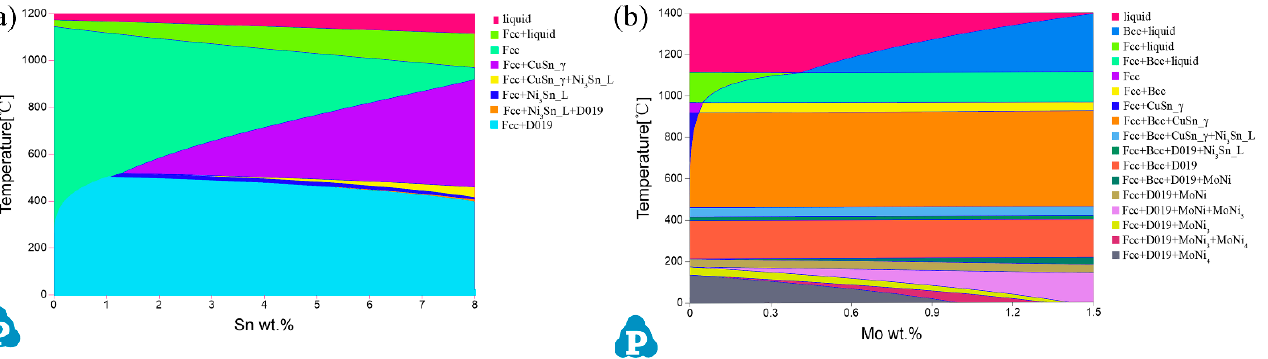
Figure 2. The simulation-calculated pseudo-binary phase diagrams of ( a ) Cu–15Ni–xSn (x = 0–8 wt.%) and ( b ) Cu–15Ni–8Sn–xMo (x = 0–1.5 wt.%) systems.